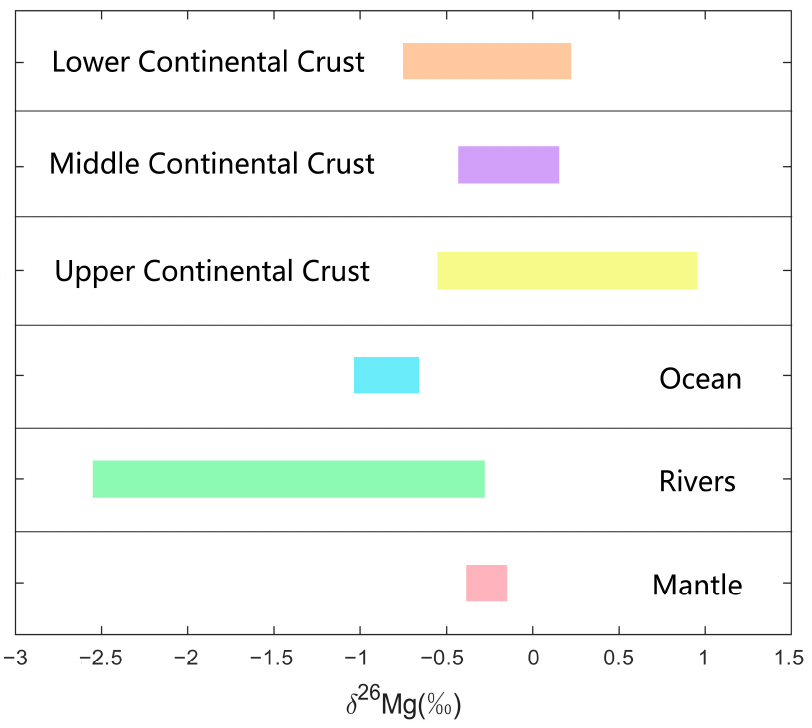
Figure 9. Magnesium isotopic compositions of major reservoirs (data from